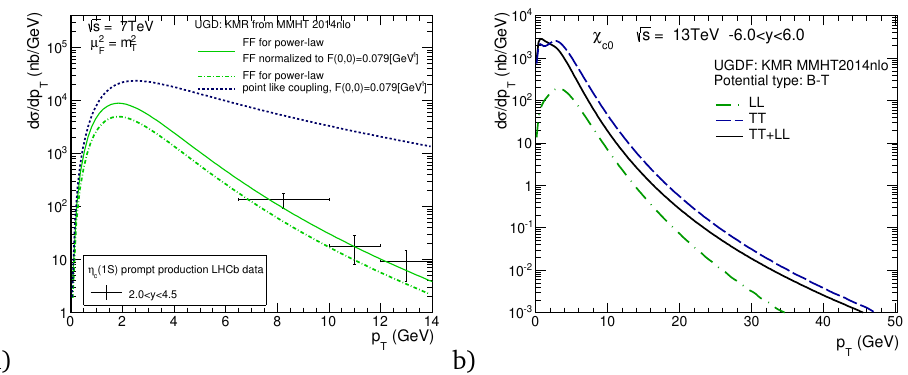
production in pp collisions at (cid:112) c pro- c 0